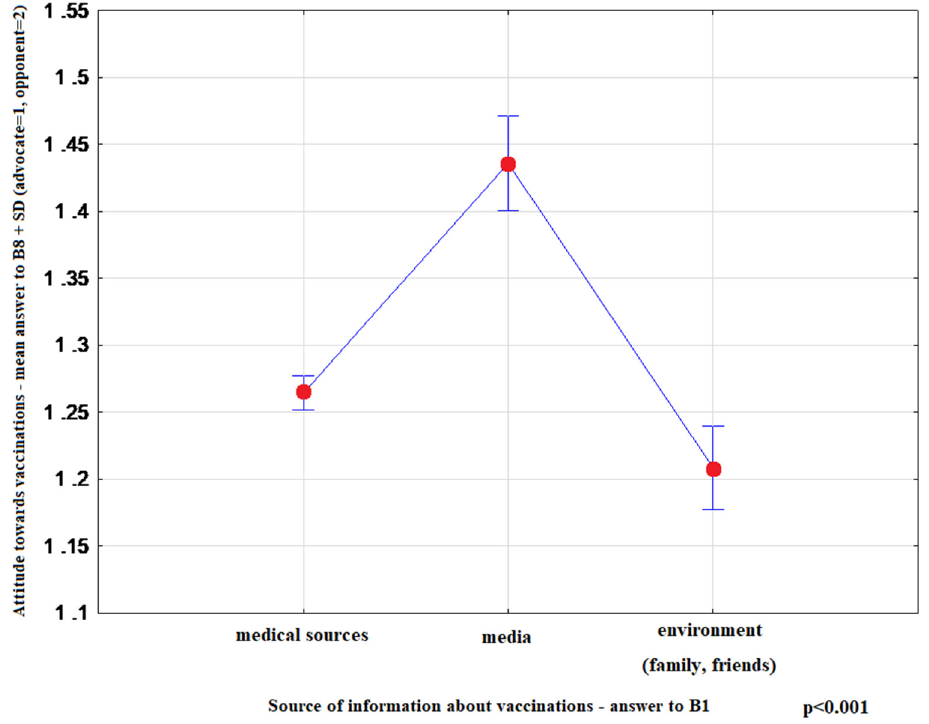
Figure 1. Mean rank-answer to the question about the attitude toward vaccination (B8) + SD depending on the preferred source of information on vaccination (B1). (medical sources n = 4718; media n = 668; environment n = 818).